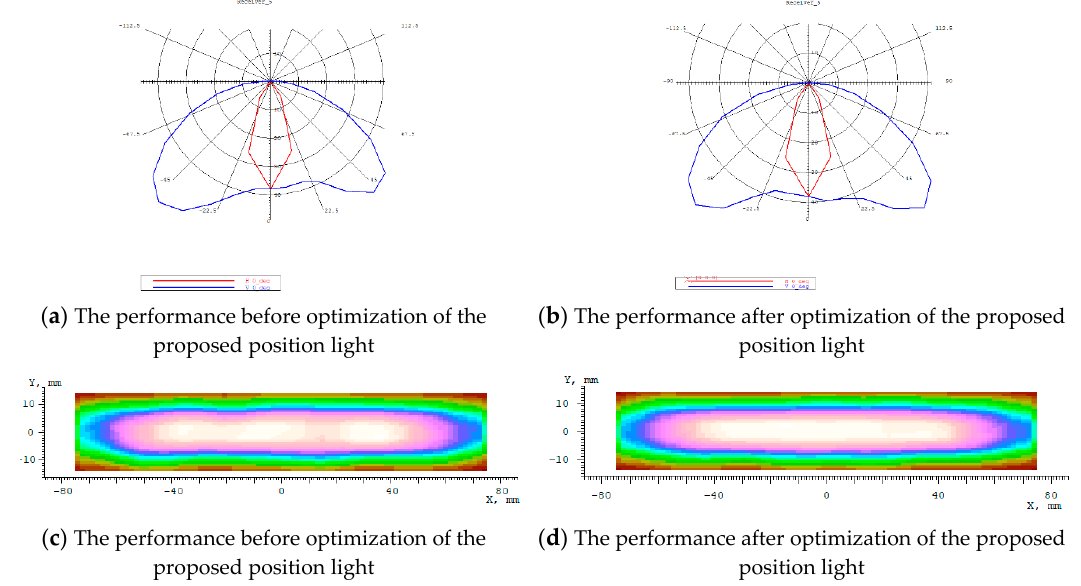
distribution of the proposed position light. of the proposed position light.